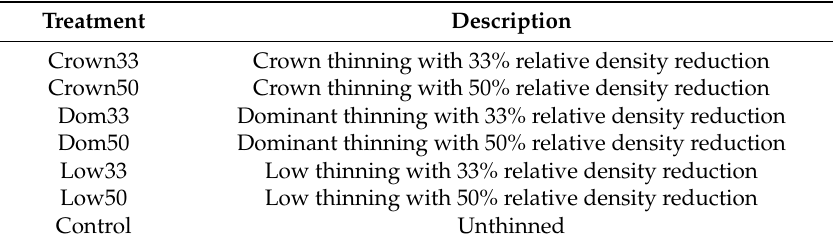
Table 1. Description of thinning treatments.